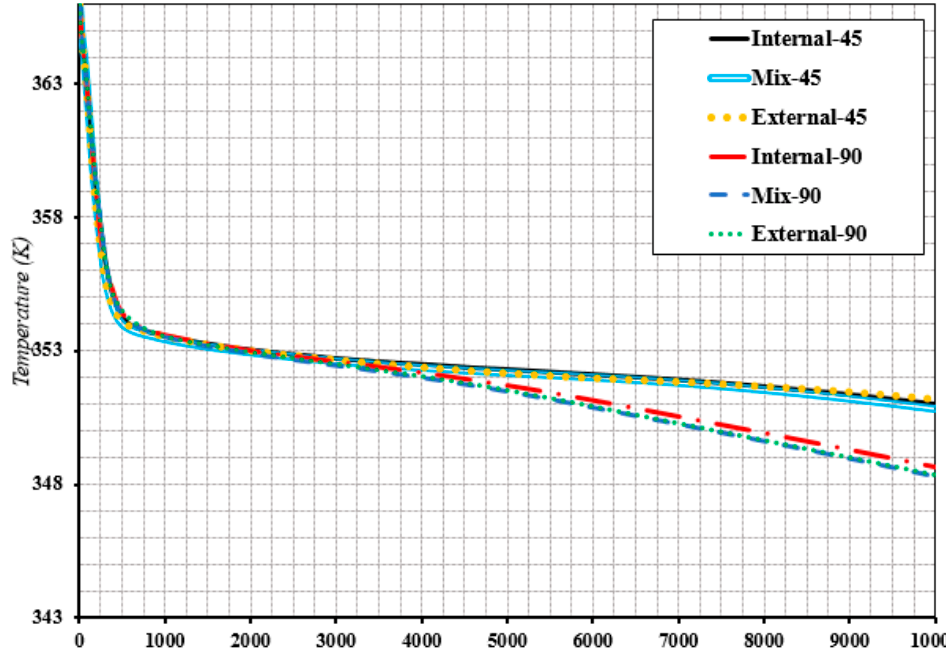
Figure 10. The average temperature of the PCM area with different fins’ configurations with the same dimensions (1 mm × 42 mm) during the time.